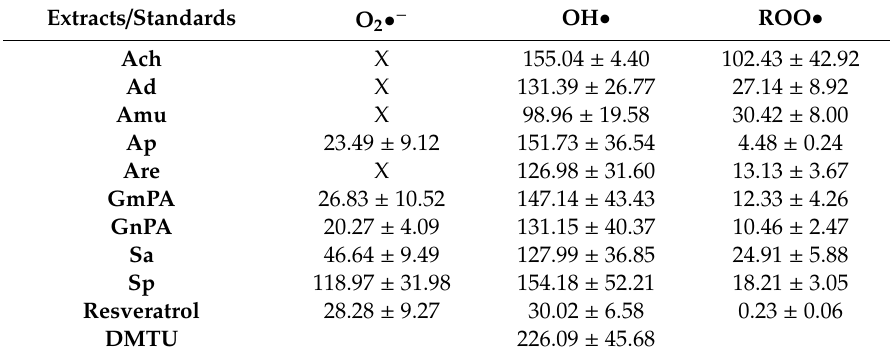
Table 2. Scavenging ability (IC 50 ) of plant extracts and reference